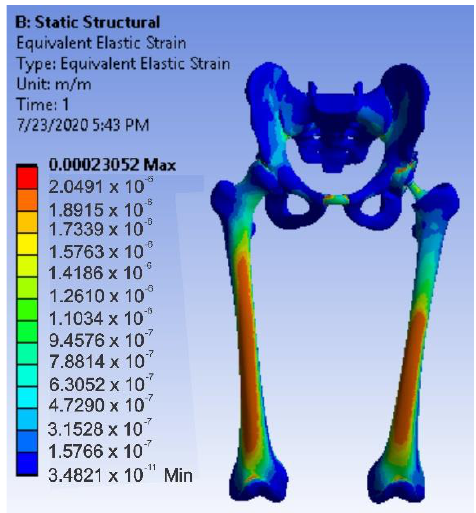
Figure 47. Strain map for the system with morcellated bone graft.